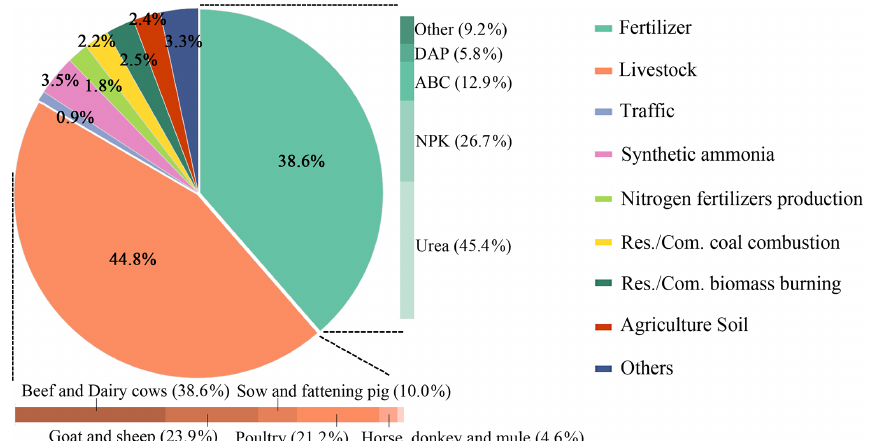
Figure 3. Contributions of different sources (%) to NH 3 emissions in mainland China (2016).